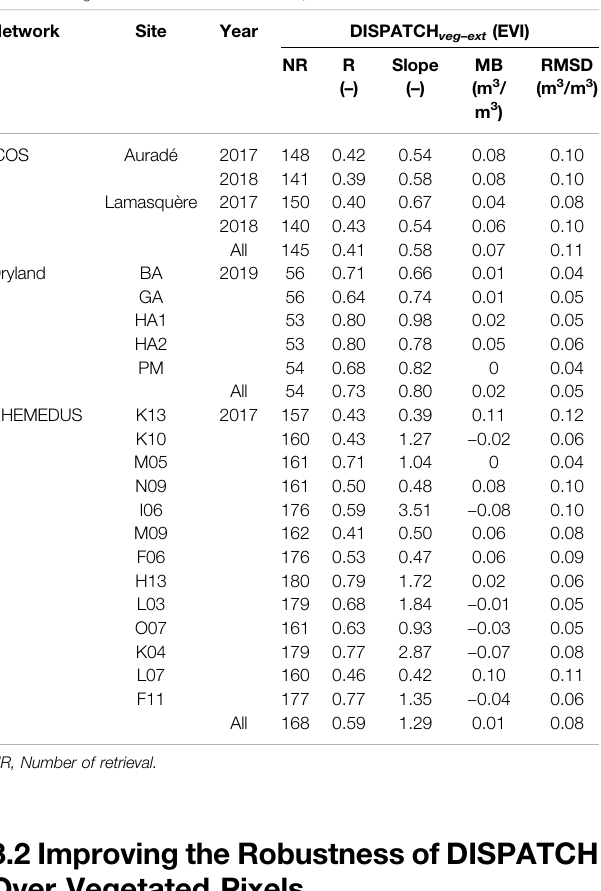
TABLE 3 | Statistical results in terms of correlation (R), slope of the linear regression (Slope), mean bias (MB) and RMSD between EVI-based DISPATCH veg – ext 1 km resolution satellite product and in situ SM.